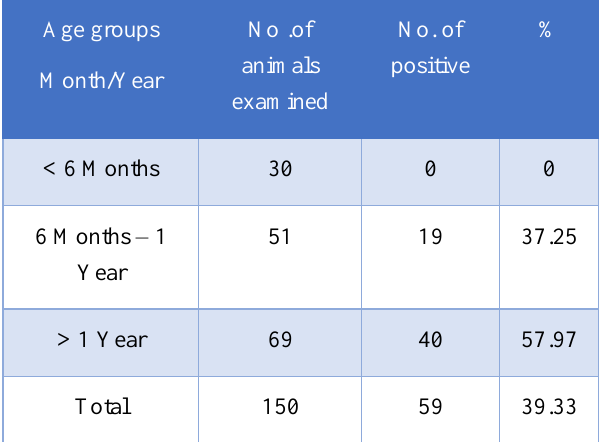
Table, 4: Infection rate of bovine theileriosis